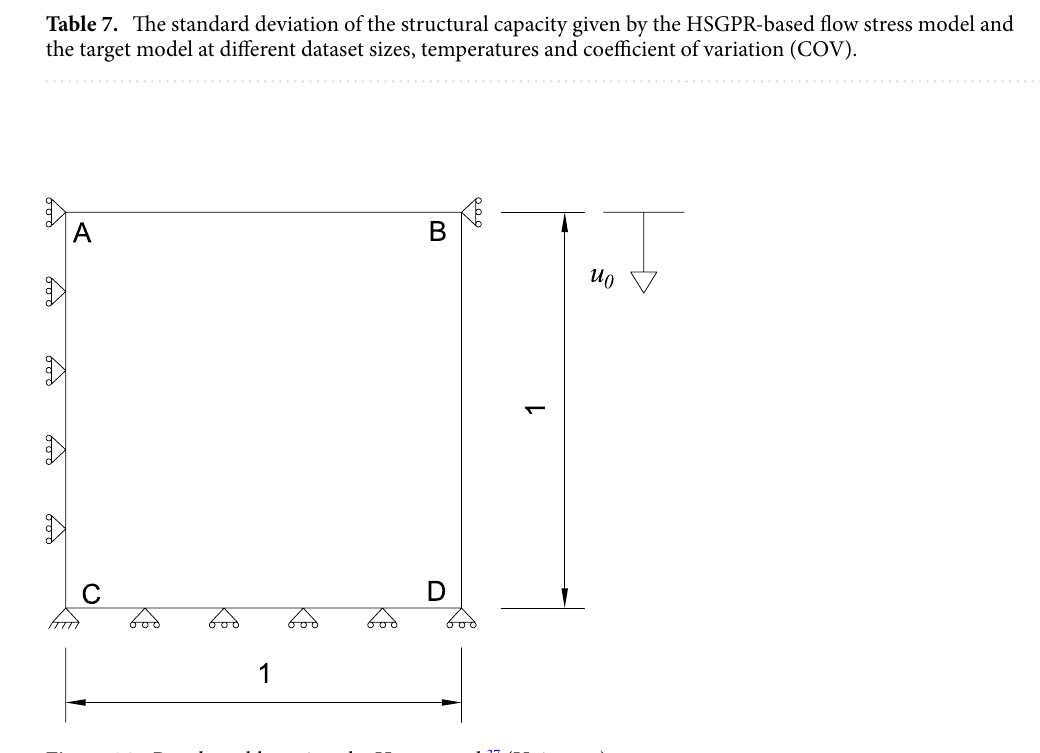
Figure 14. Punch problem given by Huang et. al. 37 (Unit: